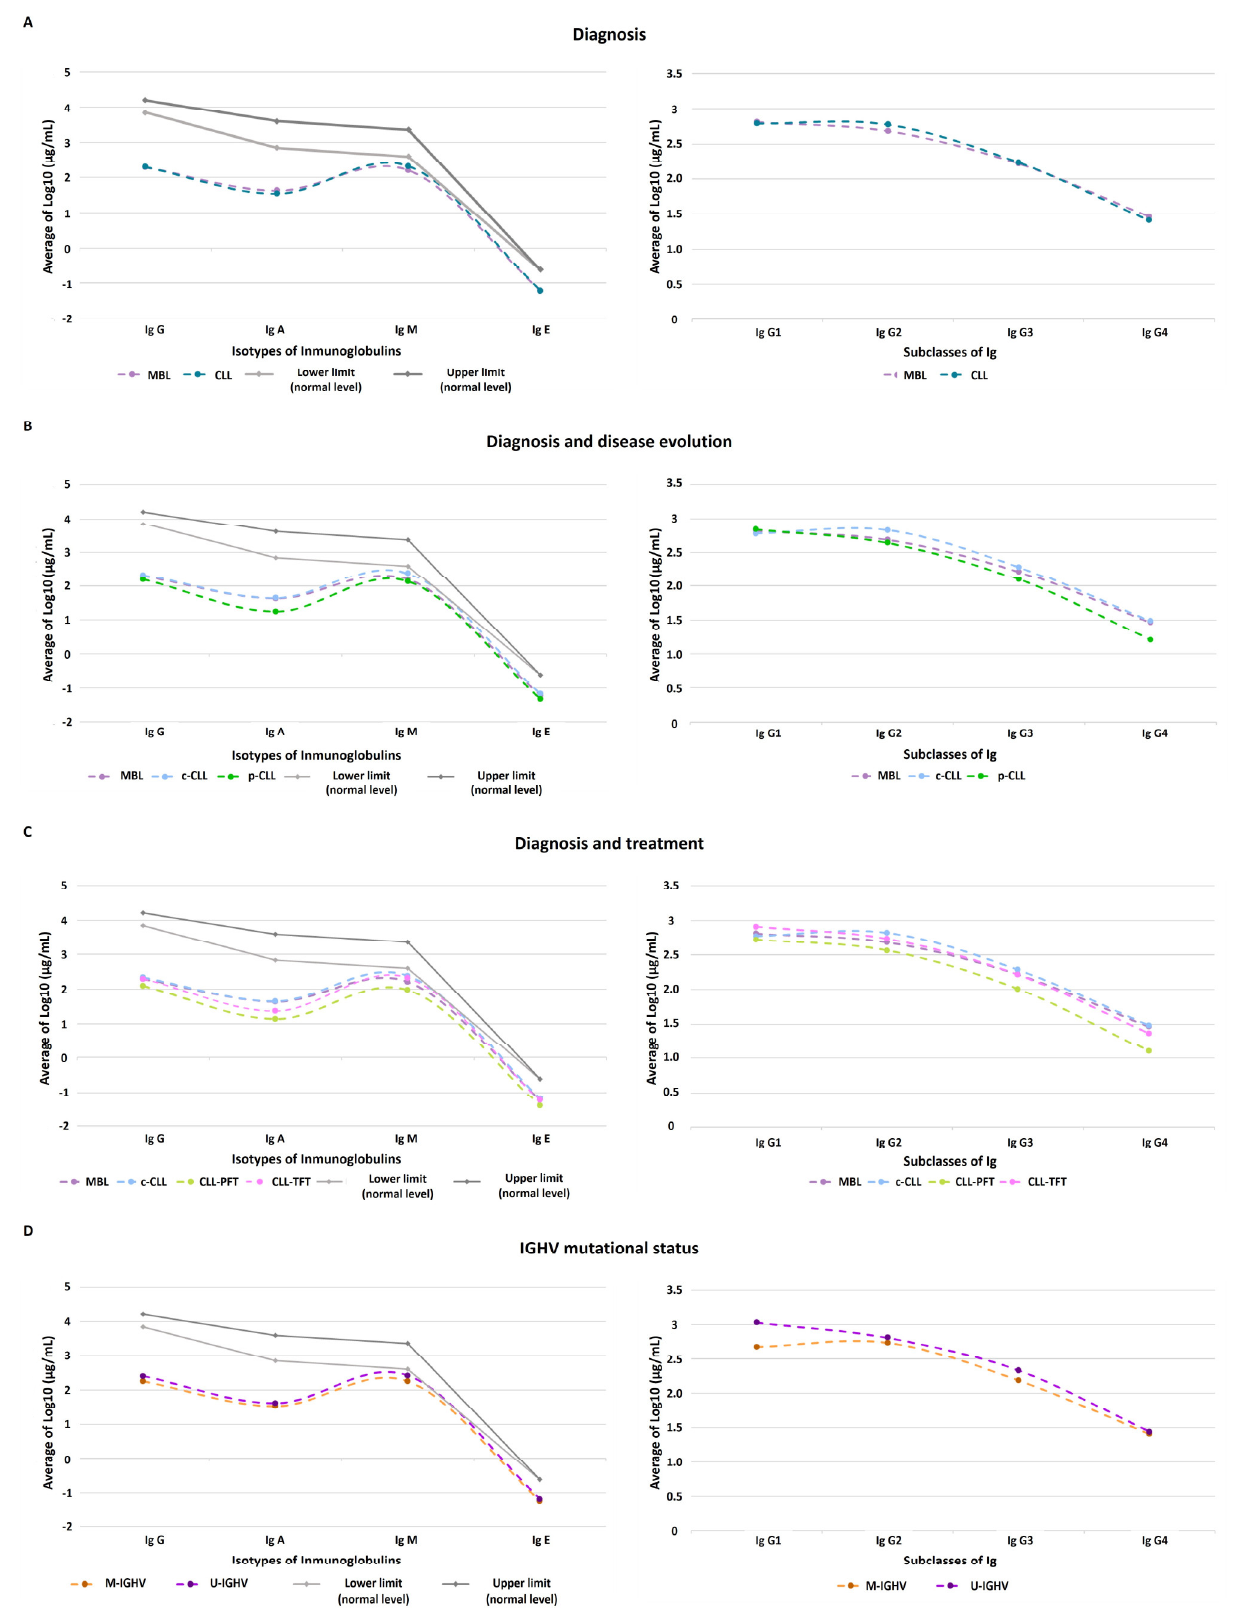
Figure 1. Quantitative immunoglobulin profiles according to clinical/diagnosis subsets: ( A ) MBL and CLL groups; ( B ) MBL, c-CLL, and p-CLL groups; ( C ) MBL, c-CLL, and treatment (CLL-PFT and CLL-TFT) groups; ( D ) IGHV mutational status (M-IGHV or